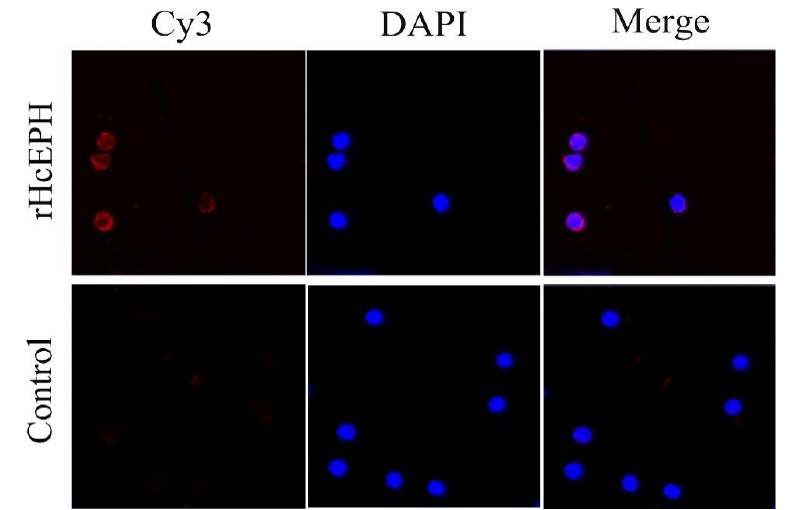
Figure 3. rHcEPH protein binding to goat peripheral blood mononuclear cells (PBMCs) in vitro by immunofluorescence assay. Binding was performed by incubating PBMCs treated with purified rHcEPH protein or sham-treated with PBS (control). Red fluorescence on surface of cells showed target protein staining (Cy3-conjugated secondary antibody) and nuclei of cells were visualized by DAPI (blue), Merge combination of red and blue channels. No protein (red fluorescence) binding was observed in control group. Scale bar 40 µm.